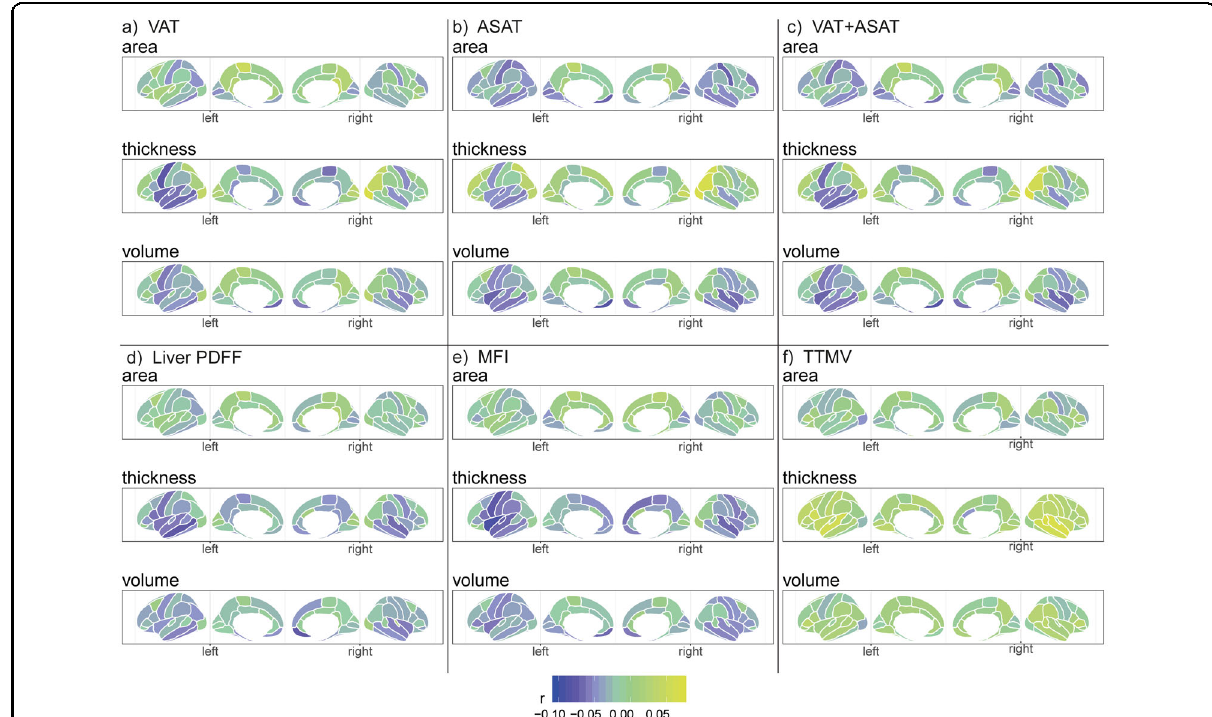
Fig. 5 Linear body – brain association patterns across cortical parcellations for body composition measures ( n = 4973). Results from model 2c that investigates body – brain connections through the inclusion of linear and quadratic body composition terms, here showing the results of the linear term for ( a ) VAT, ( b ) ASAT, ( c ) VAT + ASAT, ( d ) Liver PDFF, ( e ) MFI, and ( f ) TTMV. The regression model was adjusted for age, age 2 , sex, age-by- sex, age 2 -by-sex, intracranial volume (except cortical thickness), lifestyle/metabolic factors, Euler number, and site. Figure created using the ggseg 85 R function. ASAT abdominal subcutaneous adipose tissue, MFI Muscle Fat In fi ltration, PDFF proton density fat fraction, TTMV total thigh muscle volume, VAT visceral adipose